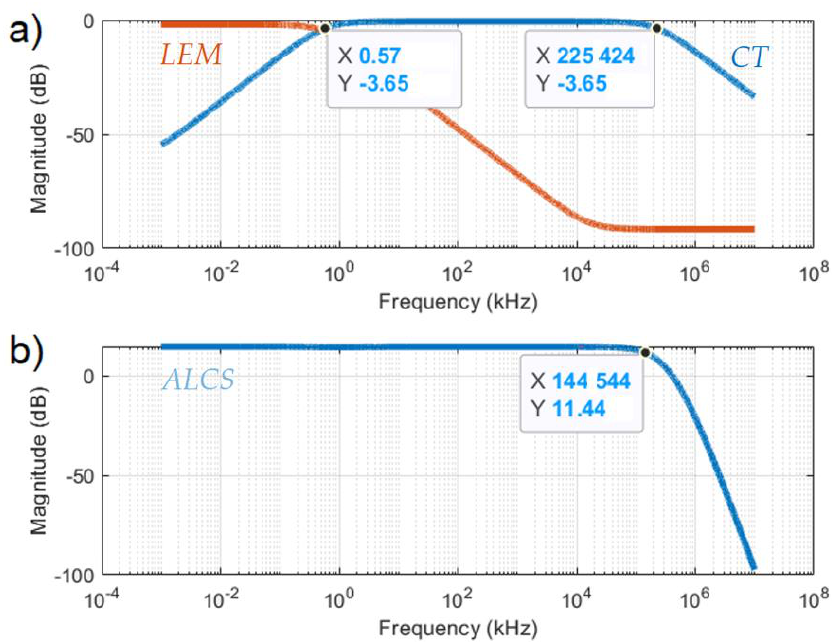
Figure 4. Magnitude as a function of frequency—( a ) LEM with CT; and ( b ) output characteristics of the ALCS–BODE plot, with marked characteristic points (−3 dB). Table 2. Comparison of the cut-off